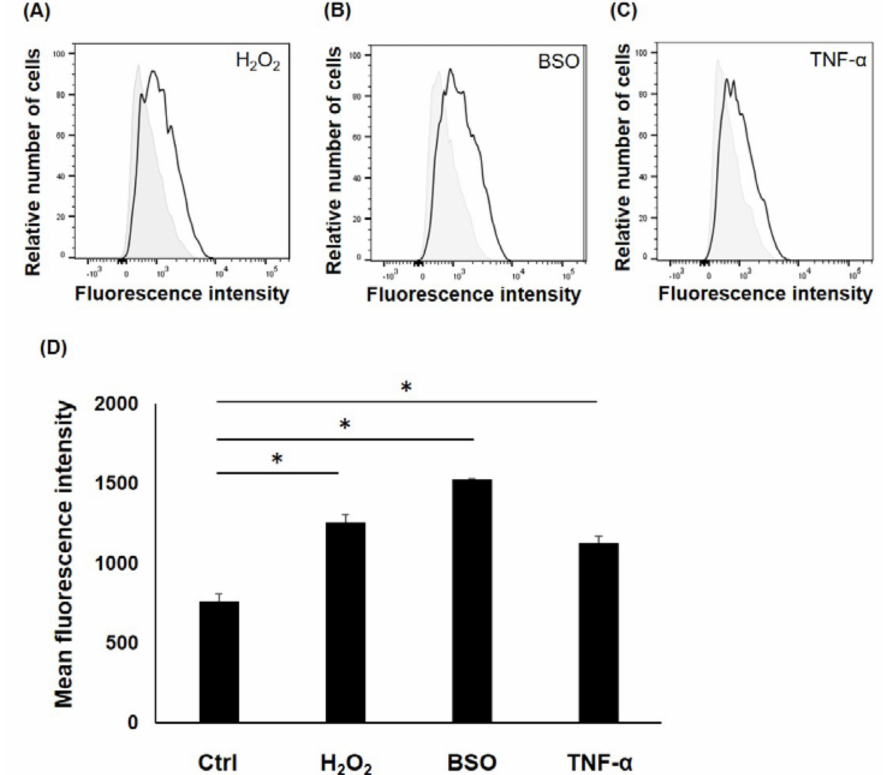
Figure 2. Flow cytometry analysis for the intracellular level of reactive oxygen species (ROS) in ligamentum flavum (LF) cells. ( A – C ) The horizontal axis represents the fluorescence intensity of the ROS probe per cell, and the vertical axis represents the relative cell number at each fluorescence intensity. Histograms filled in gray represent fluorescence data for untreated control cells, while solid black lines represent H 2 O 2 -treated ( A ), buthionine sulfoximine (BSO)-treated ( B ), and TNF- α -treated cells ( C ). ( D ) Treatment of H 2 O 2 , BSO, and TNF- α significantly increased intracellular ROS levels in the cells. *